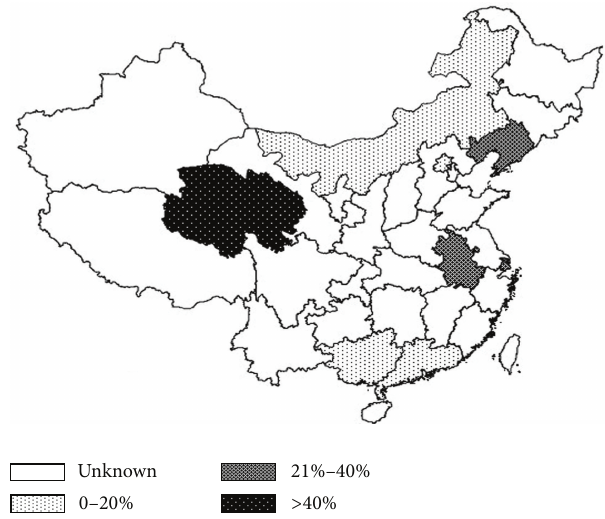
Figure 4: A map displaying the prevalence rates and geographic locations in China from 12 studies included in the